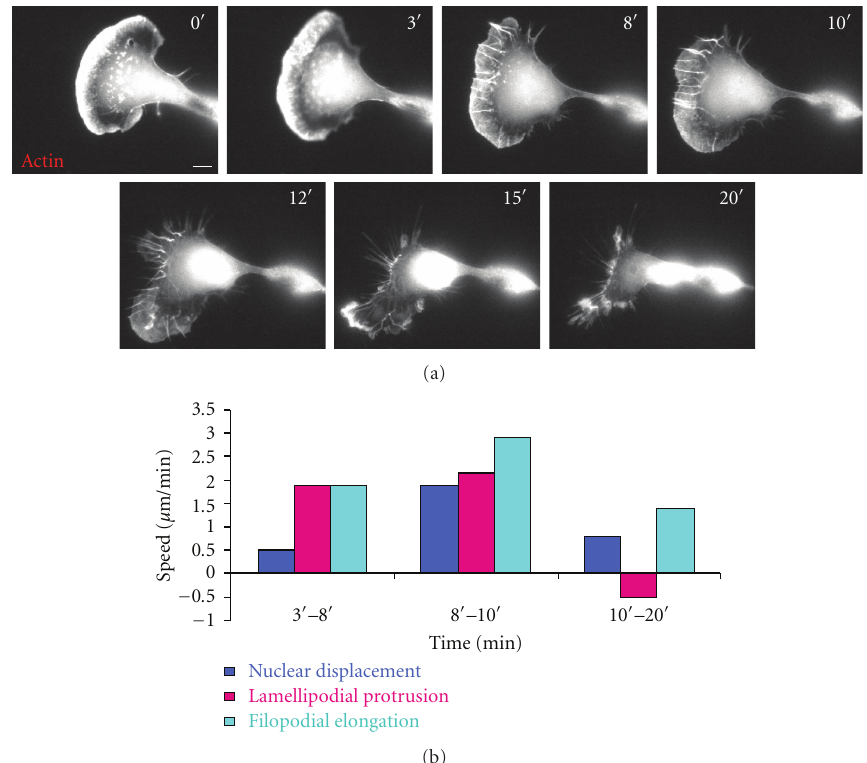
Figure 2: Filopodial behavior during cell migration followed by leading edge retraction. (a) High magnification image sequences of B16F1 cell transiently transfected with mCherry-actin. The projection of filopodia beyond the edge of the lamellipodium followed by retraction of the leading edge. The entire movie can be found in Supplementary Data, Movie 1. (b) Cell retraction, speed and filopodial behavior over three time periods. Light blue, pink and turquoise represent speed of nucleus displacement, lamellipodial protrusion and filopodial elongation, respectively. The frame position is locked so movement toward the edge represents lamellar extension/retraction. Scale Bar 10 μ